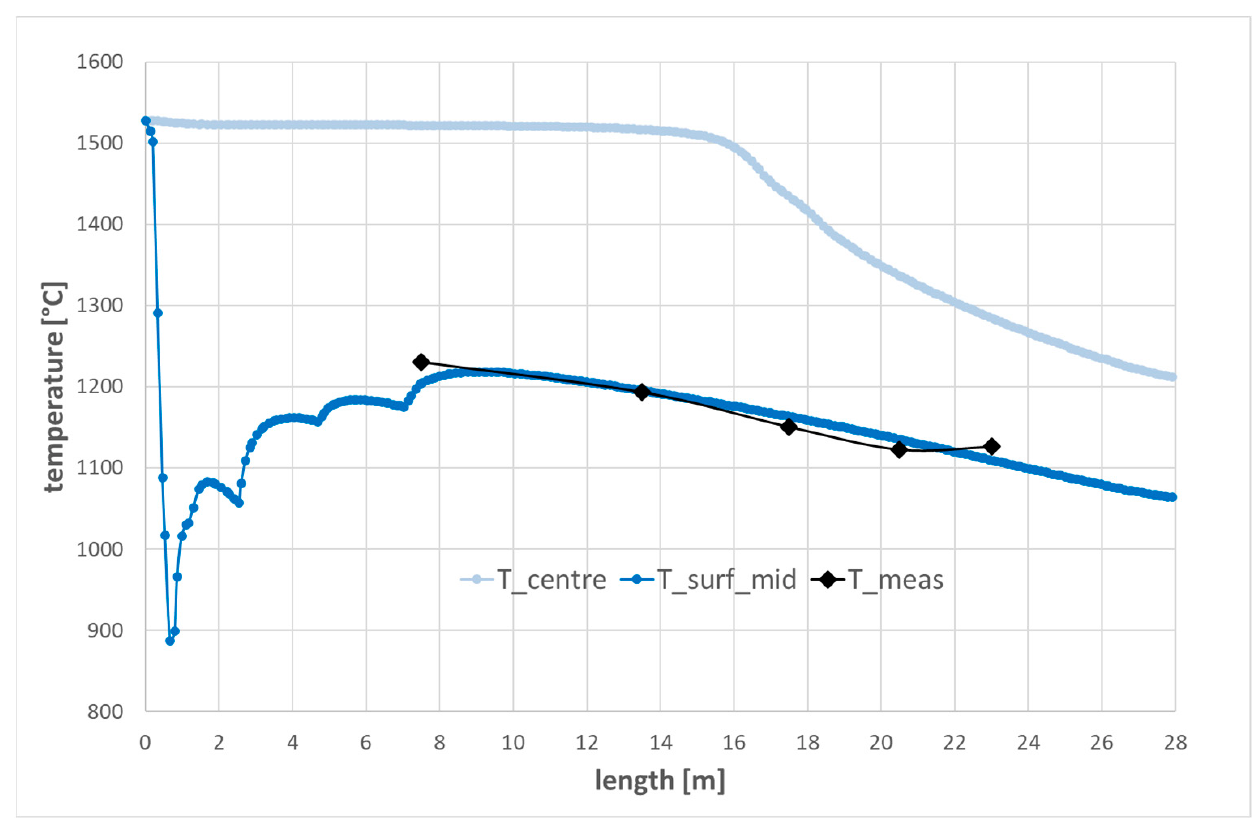
Figure 5. Simulated temperature profile compared to measurements of strand surface temperatures with IR camera at ESF billet caster.